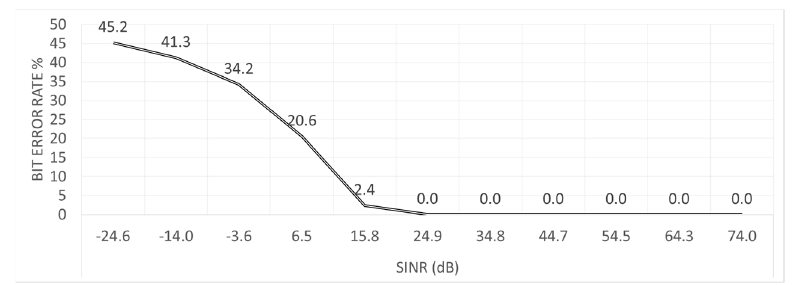
Figure 12. BER percentage and SINR (dB) relationship.